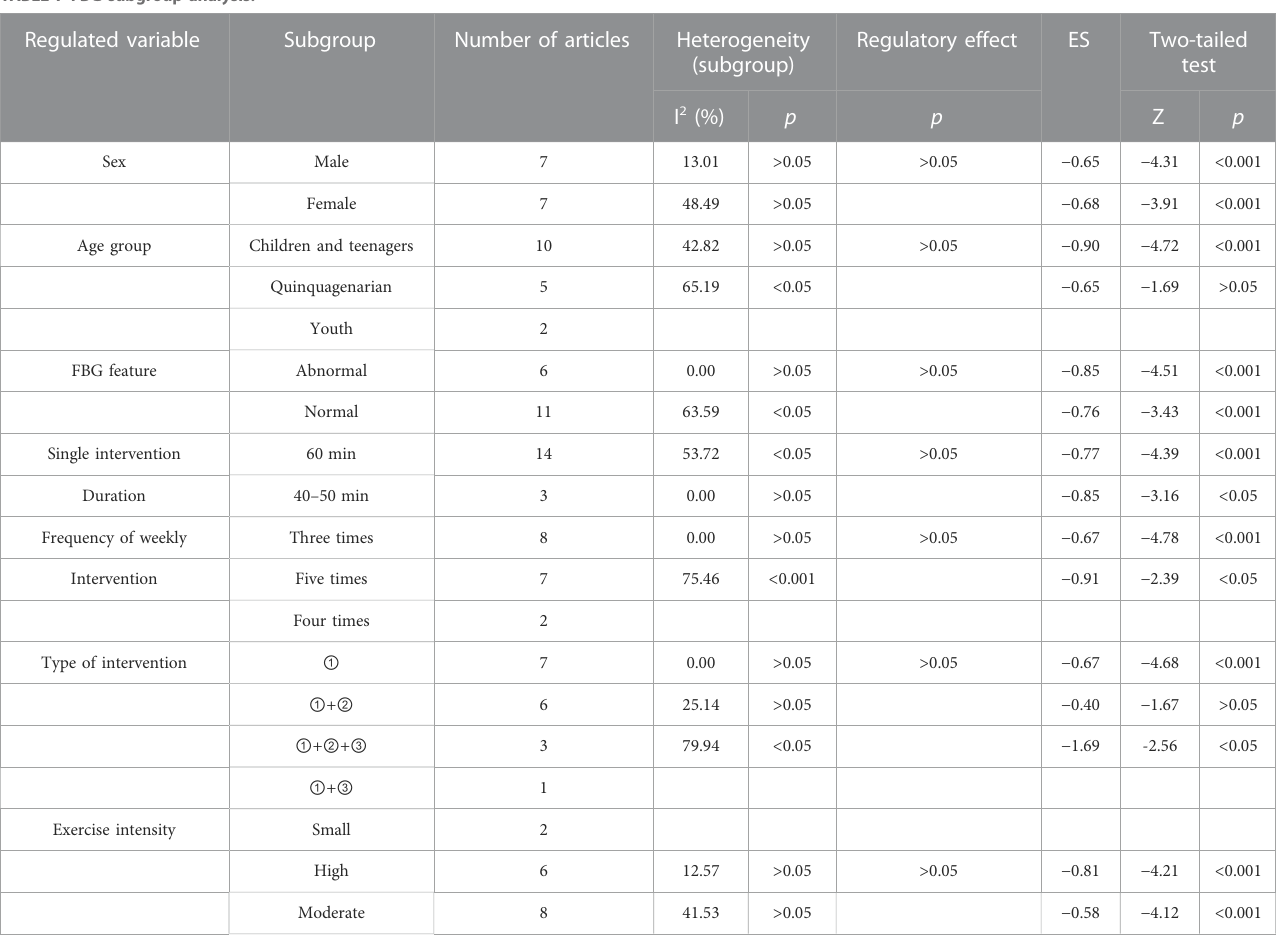
TABLE 7 FBG subgroup